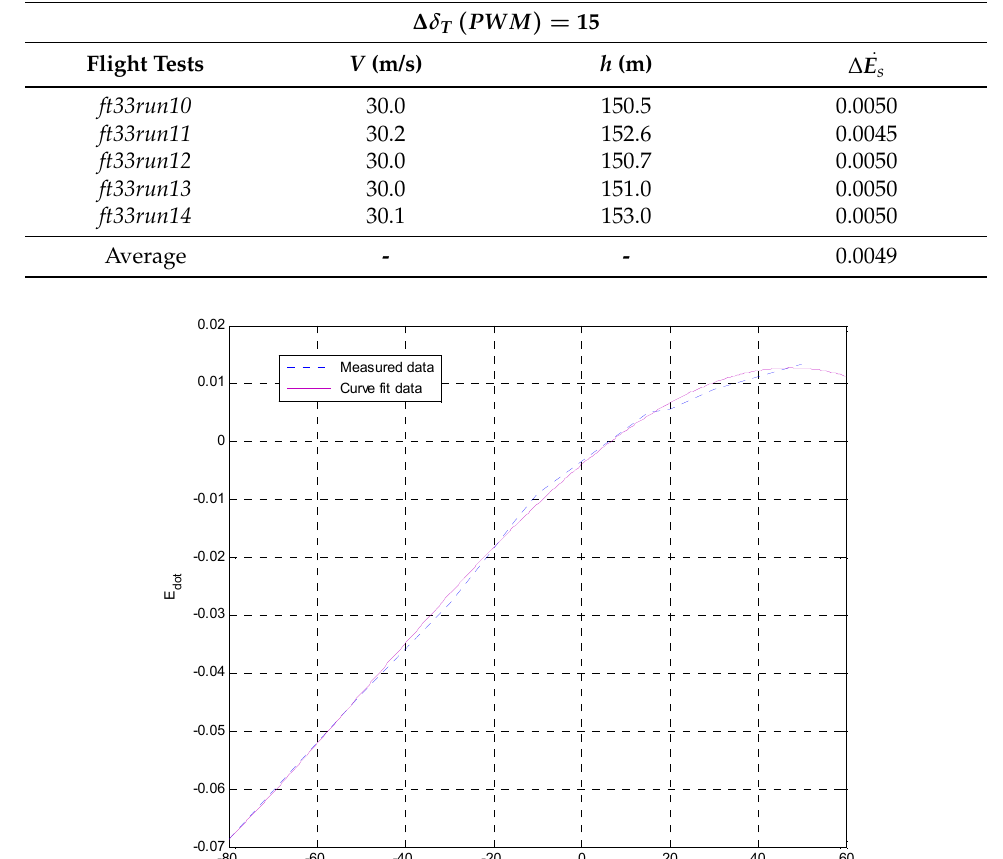
Figure 8. Curve fit relation of ∆(cid:1831) (cid:2929) (cid:4662) and ∆δ T .